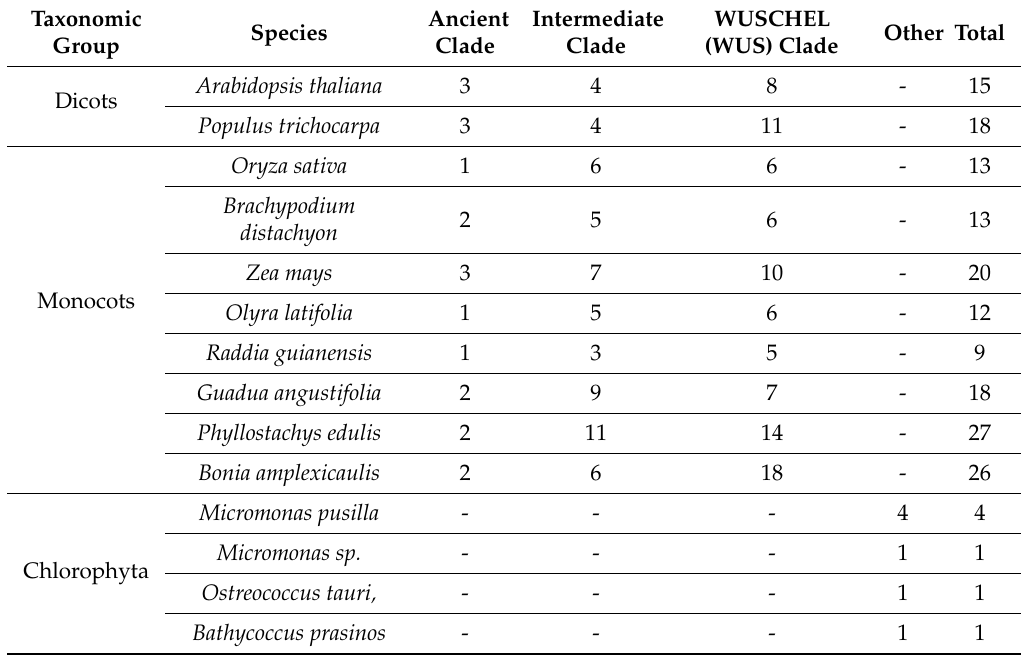
Table 1. Comparison of the WOX s of Bambusoideae with other